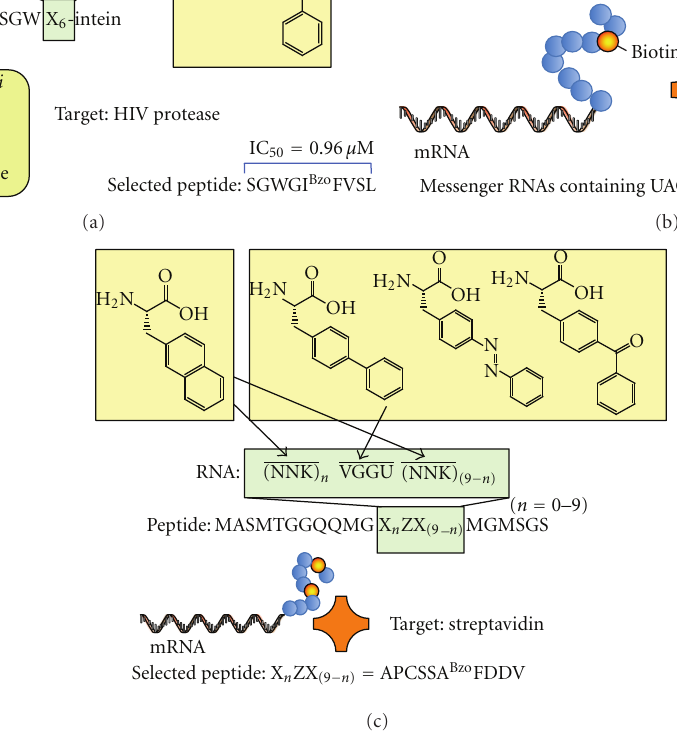
Figure 2: Selection of nonstandard peptides from libraries generated by genetic code expansion. (a) Selection of backbone-cyclized L- p - benzoylphenylalanine-containing peptide inhibitors. Orthogonal tRNA(CUA)/aaRS pairs were expressed in E. coli in order to assign L- p - benzoylphenylalanine to the amber codon. SICROPPS was used to cyclize the peptides. (b) Proof-of-concept study of mRNA display with a nonproteinogenic amino acid. Biocytin was assigned to the amber codon by adding biocytin-tRNA(CUA) to a rabbit reticulocyte lysate. The peptides were expressed in mRNA display format and pulled down using streptavidin beads. (c) Selection of streptavidin binding non- standard peptides. Four nonproteinogenic amino acids were assigned to the amber codon and four-base codons (UAG, L-2-naphthylalanine; AGGU, L- p -biphenylalanine; CGGU, L- p -benzoylphenylalanine; GGGU, L- p -phenylazophenylalanine). All corresponding nonproteinogenic aa-tRNAs were added to an E. coli cell-free translation system. The peptide libraries were expressed in mRNA display format and used for in vitro selection against streptavidin. X represents one of the proteinogenic or nonproteinogenic amino acids, and Z represents one of the nonproteinogenic amino